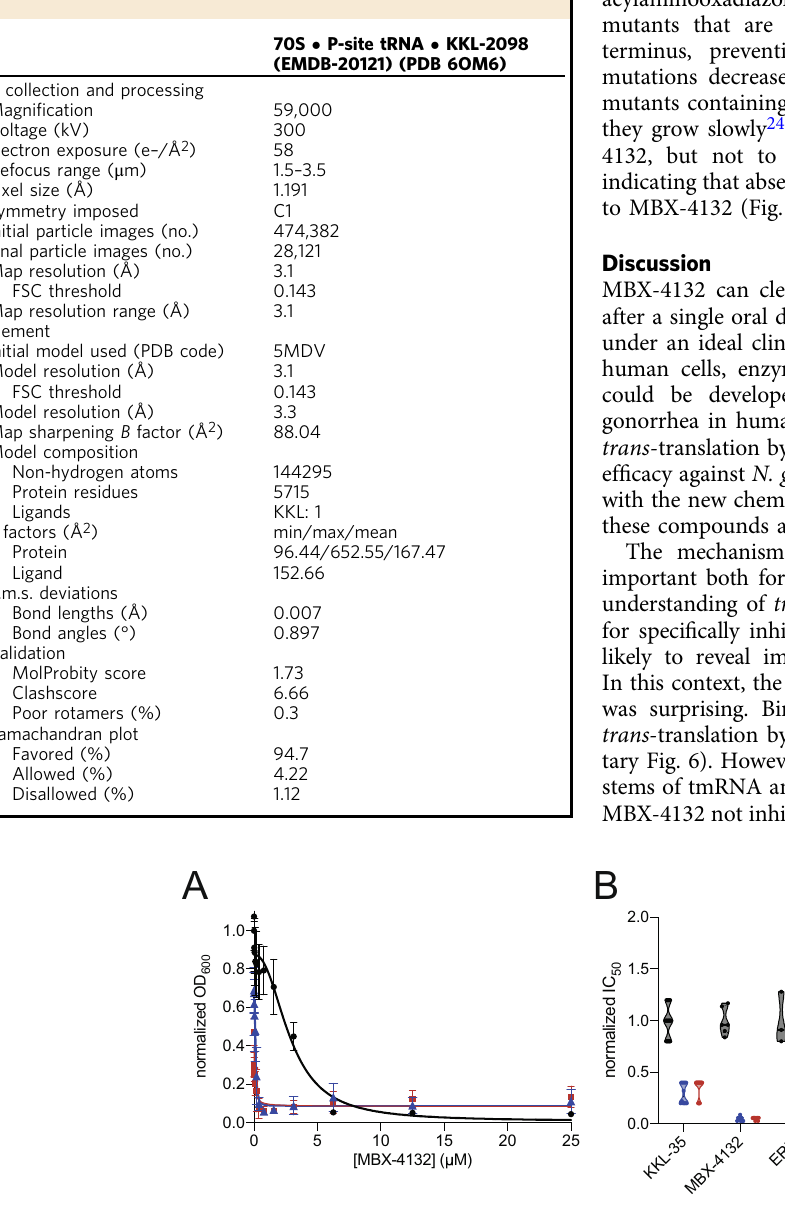
Fig. 4 Truncation of bL27 causes hypersensitivity to acylaminooxadiazoles. A Growth of E. coli Δ tolC expressing full-length bL27 (black) or variants missing residues 2 – 4 (-3, blue) or 2 – 7 (-6, red) was monitored in broth microdilution experiments and the IC 50 for MBX-4132 was determined. At least two technical replicates were performed for each biological replicate and the average of at least three biological replicates is shown with error bars indicating standard deviations. B Violin plot showing normalized mean IC 50 values from at least 3 biological replicates of experiments as in ( A ) show that truncation of bL27 increases sensitivity to KKL-35 and MBX-4132 but has no effect on erythromycin (ERM), linezolid (LZ), spectinomycin (SPEC) or tetracycline (TET). Source data are provided as a Source Data fi le.